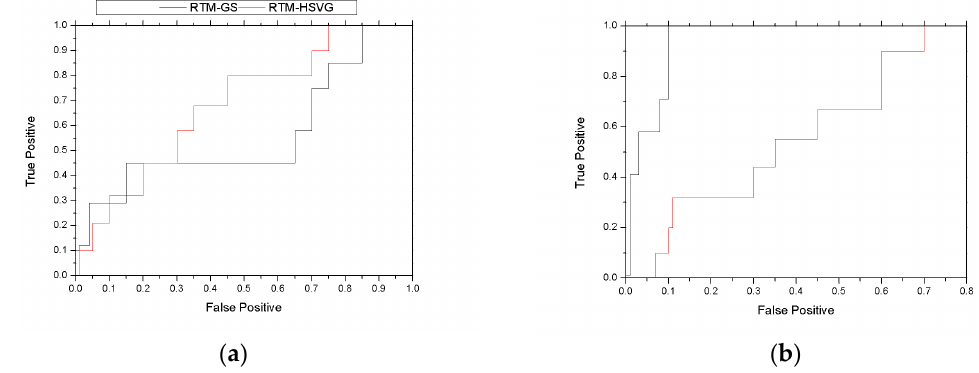
Figure 7. Comparative results of ROC. ( a ) Comparative results on NLL. ( b ) Comparative results on r_NLL.